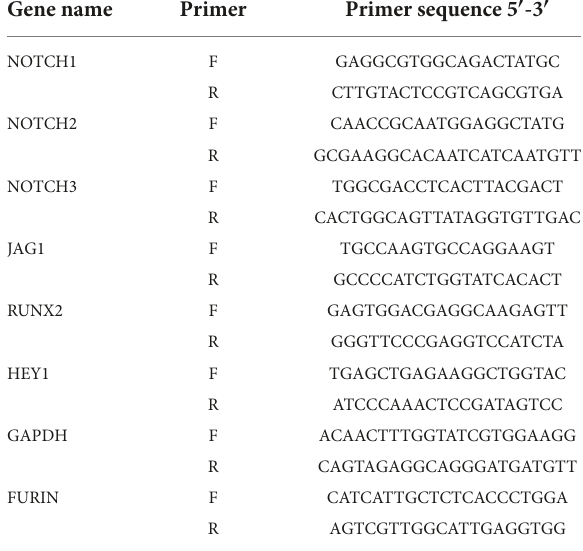
TABLE 1 Primers used for quantitative polymerase chain reaction